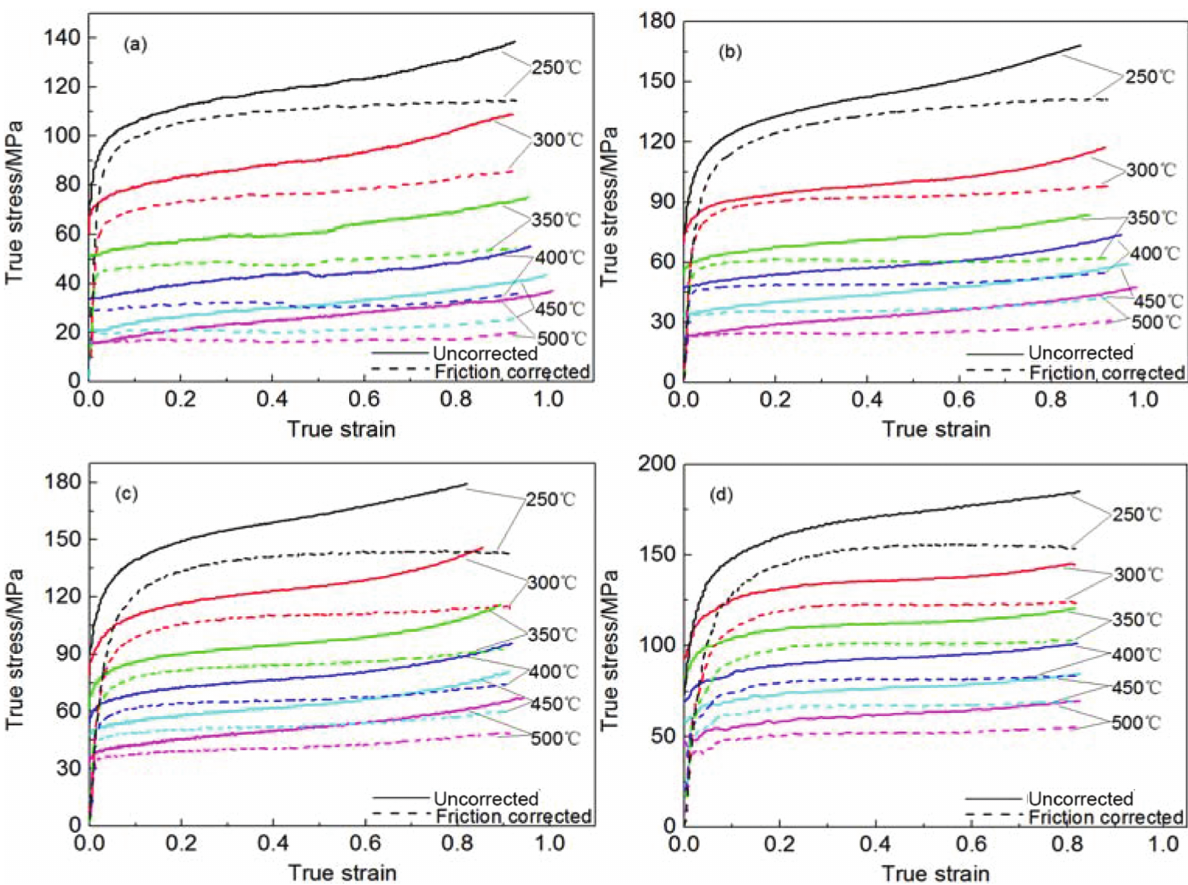
Figure 1: Original and friction-corrected stress – strain curves: (a) 0.01 s − 1 ; (b) 0.1 s − 1 ; (c) 1 s − 1 and (d) 10 s − 1